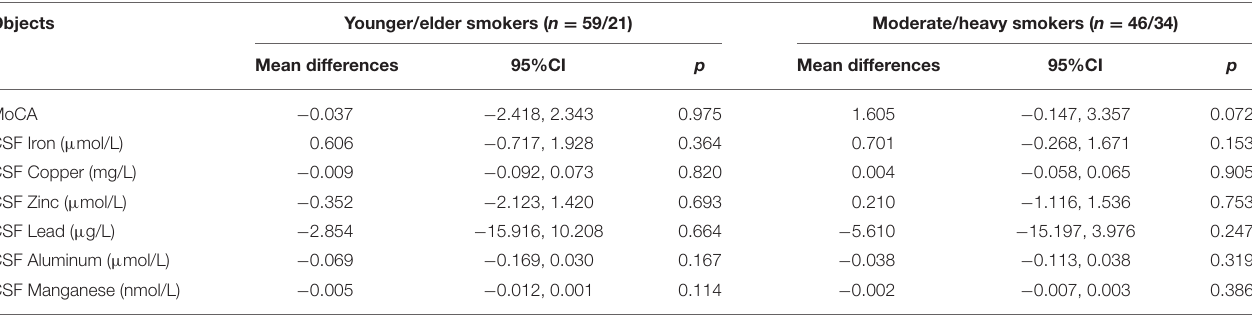
TABLE 3 | The differences of CSF biomarker levels between subgroups in active